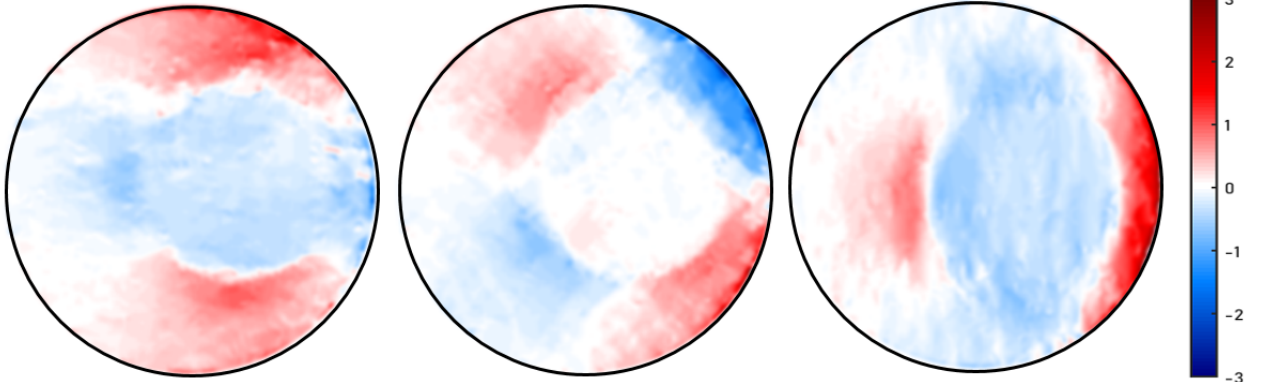
Figure 12. Thereconstructedfull-fieldtwo-dimensionalstraincomponents( ε xx , ε xy , and ε yy